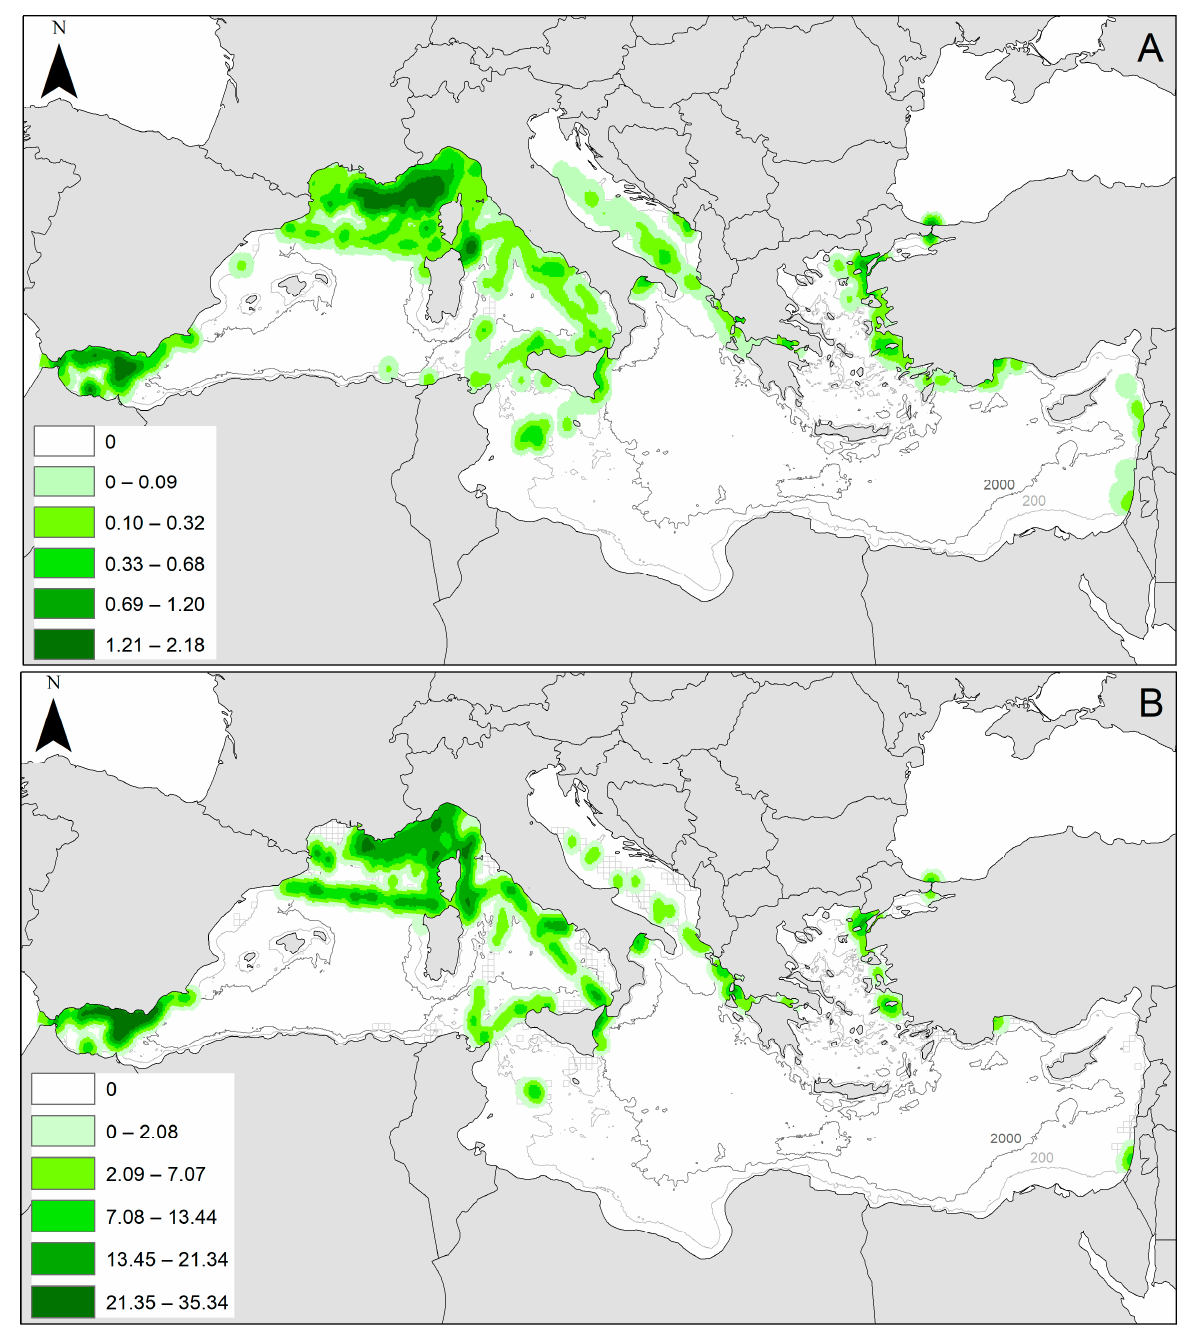
Figure 14. The map of the total encounter rate ( A ) and the map of the cetacean diversity according to the Shannon index ( B ). As a general pattern, both the ER and diversity index have their maximum values in the Alboran Sea (in the westernmost area of the basin) and they seem to decrease moving eastwards inside the Mediterranean (Kernel density parameters: cell size x, y = 5 × 5 km; radius ≈ 40 km; criterion for division into classes: natural breaks).